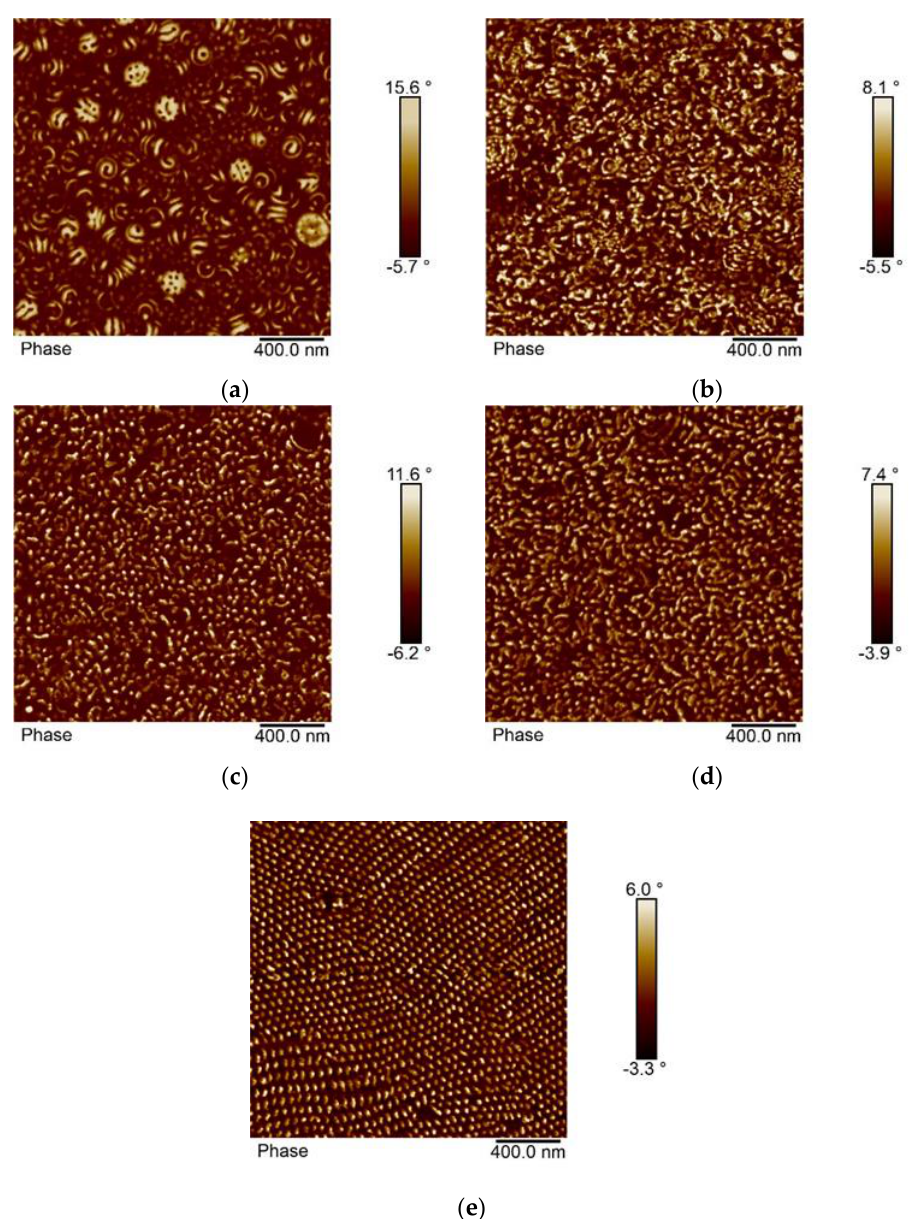
Figure 8. AFM phase images of the sample p(St30-2EHA70). ( a ) Top surface of the latex film dried at room temperature; ( b ) cross-section of the latex film dried at room temperature; ( c ) cross-section of the latex film dried at room temperature and annealed at 100 °C for 30 min; ( d ) cross-section of the latex film dried at room temperature and annealed at 100 °C for 96 h; and ( e ) cross-section of a film cast from THF solution.